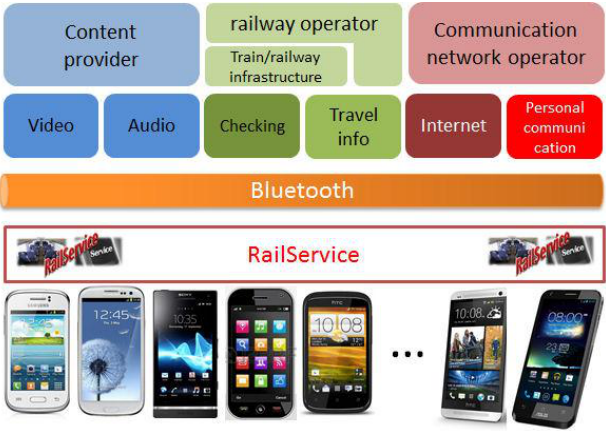
Figure 16. RailService’s architecture.